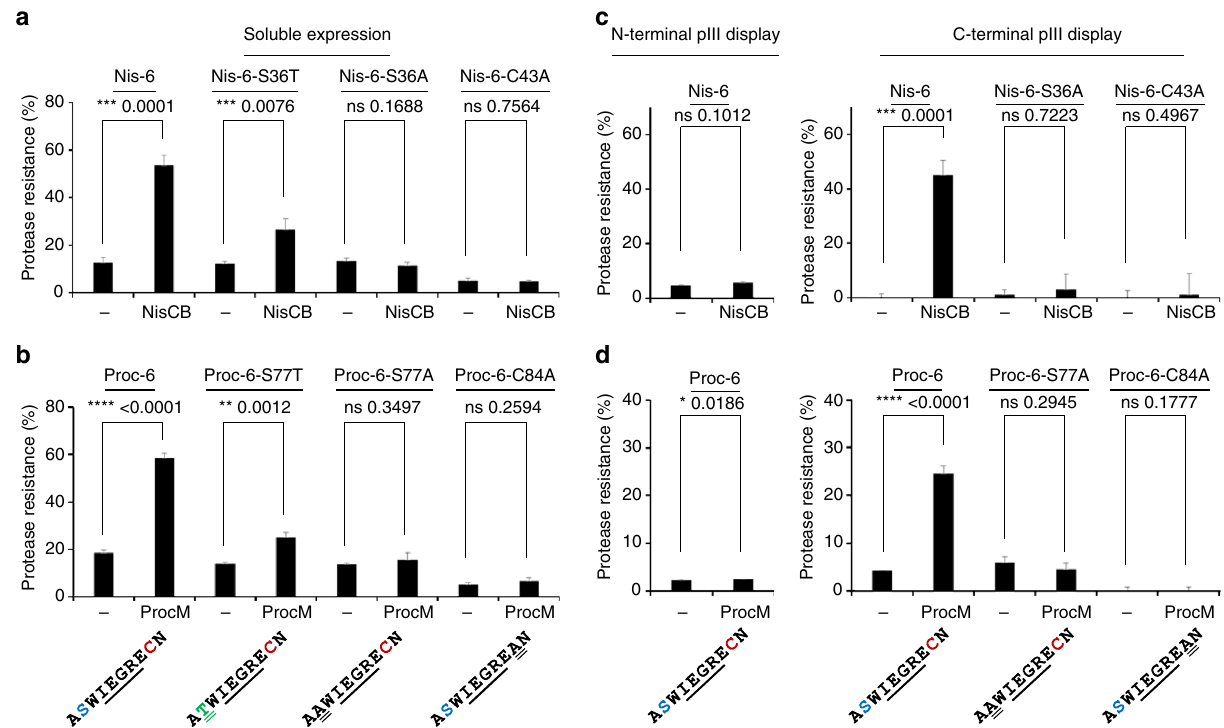
Fig. 2 Assessment of the cyclization status of arti fi cial lanthipeptides in cell lysates and displayed on phage. a Precursor peptides (full sequences in Supplementary Table 1) containing the NisA leader and indicated core sequences (residues involved in thioether formation colored) fl anked by af fi nity tags were expressed with or without NisBC, captured from cell lysates, and subjected to FXa digestion and ELISA detection. The protease resistance relative to untreated (no FXa) samples was calculated and data representing mean ± s.d. of three independent cultures analyzed in duplicate is shown (unpaired, two- tailed t -test). b As in a , but core sequences were fused to the ProcA leader (full sequences in Supplementary Table 2) and expressed with or without ProcM enzyme. c Peptides containing the NisA leader sequence were translationally fused to the N- (left panel) or C-terminus (right panel) of phage pIII (full sequences in Supplementary Table 3), phage produced with or without NisBC co-expression, and the peptide cyclization status assessed on phage particles as described in a . d As in c , but phage displayed peptides containing ProcA leader sequences (full sequences in Supplementary Table 4) were tested after phage production with or without ProcM co-expression. Experiments shown in a – d were repeated three